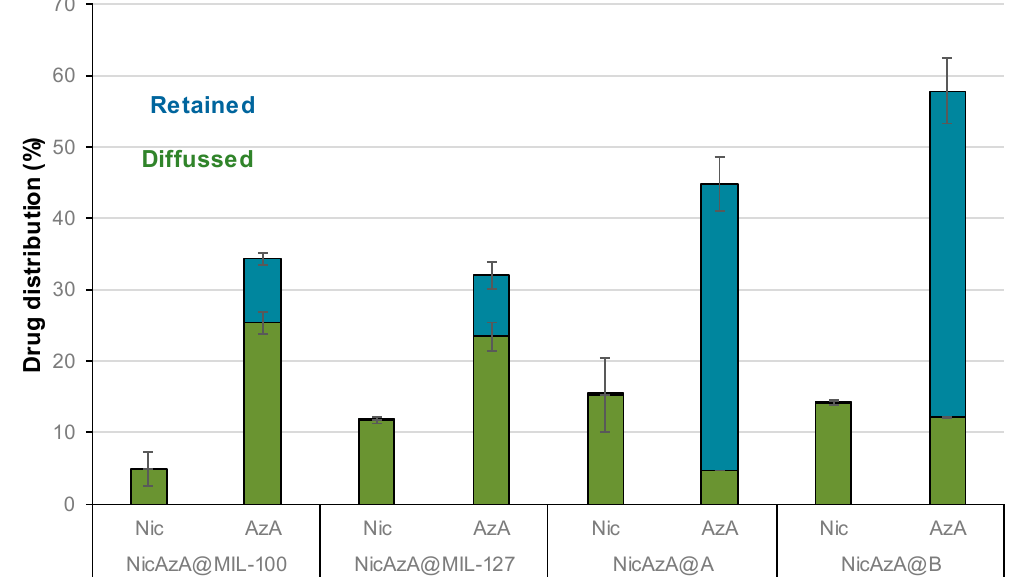
Figure 8. Skin distribution of Nic and AzA (%) after 24 h of ex vivo permeation tests.